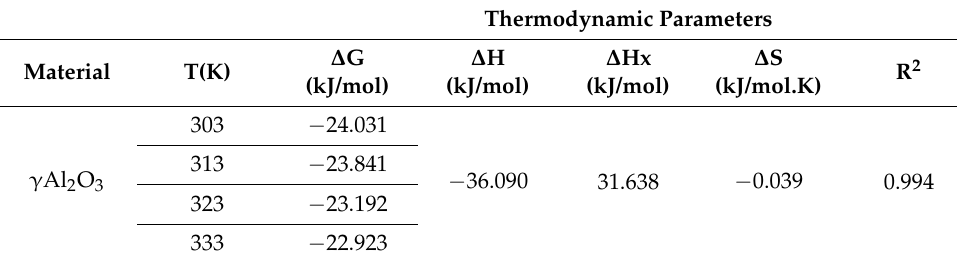
Table 5. Thermodynamic parameters of Tl(I) adsorption by nano